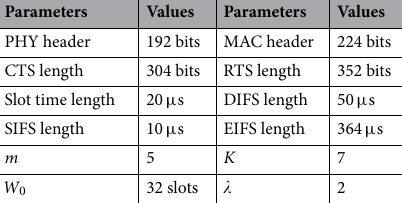
Table 2. Main simulation